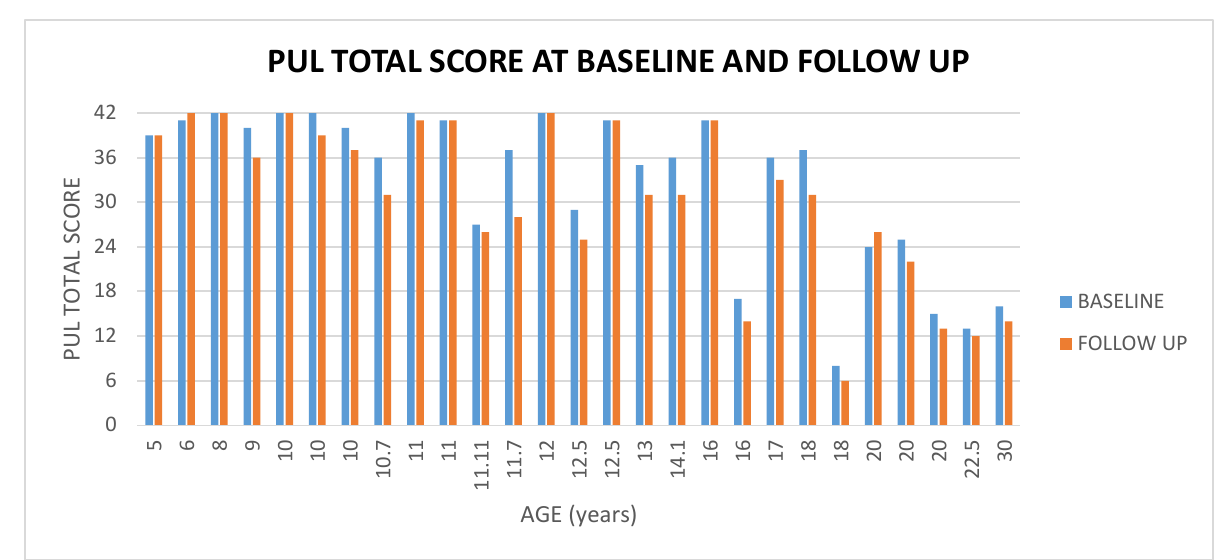
Figure 3. showed PUL total score at baseline and at follow up according to age. Figure 3. Showed PUL total score at baseline and at follow up according to age.